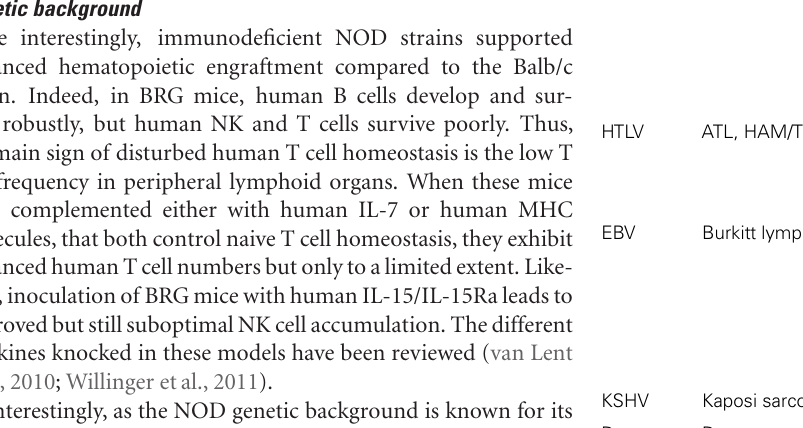
Table 1 | Infectious agents studied in humanized mice.